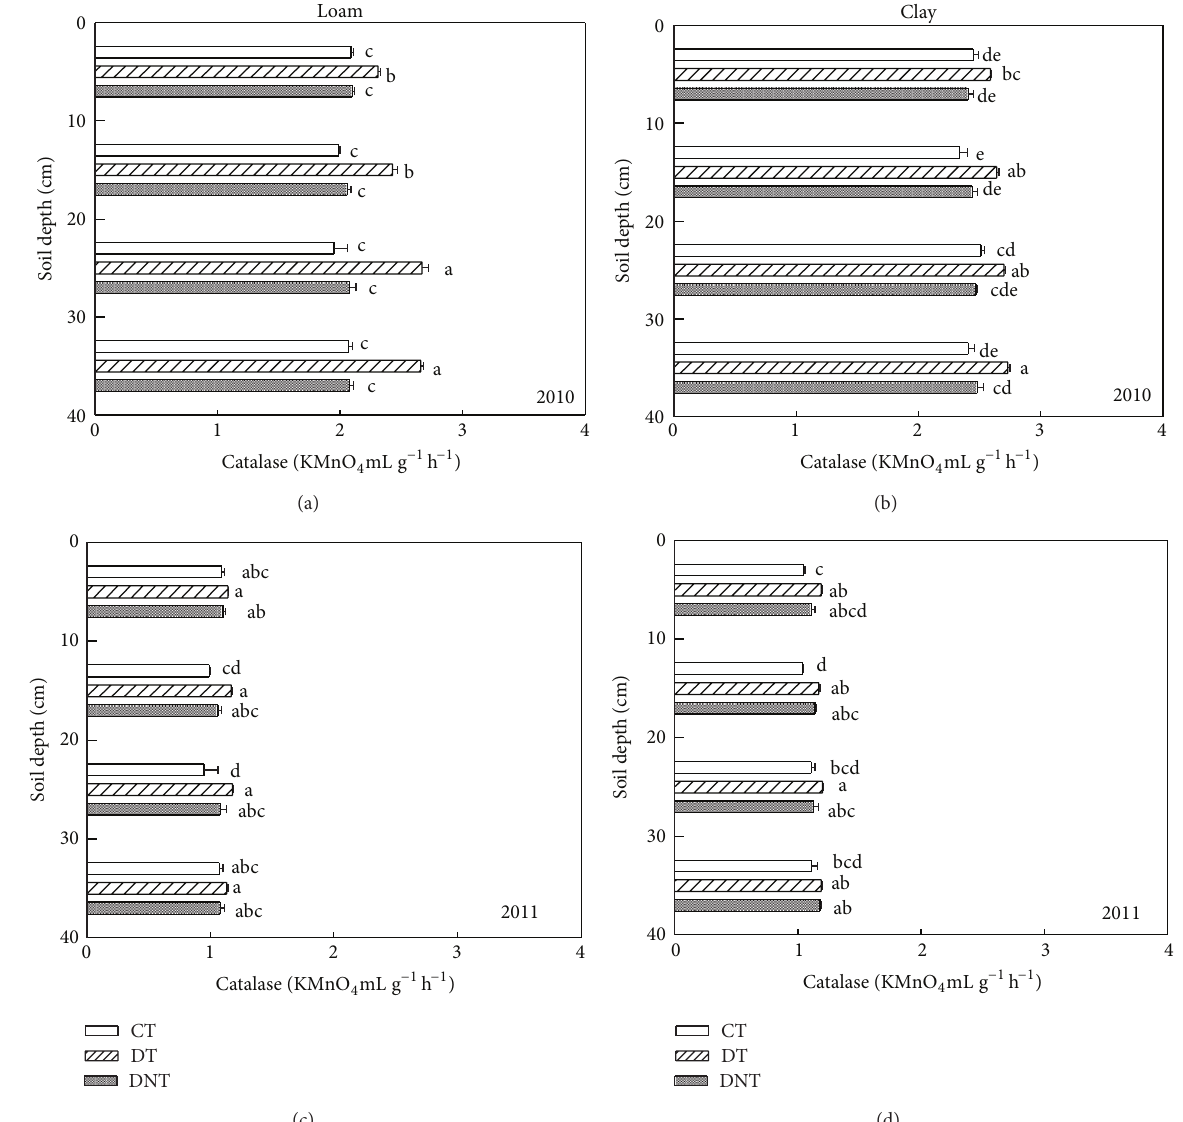
Figure 7: Effects of tillage and straw returning on soil catalase activity. Different small letters indicated significant difference at 𝑃 < 0.05 according to Duncan’s test. CT represented conventional tillage, moldboard ploughed to a depth of 20 cm, and straw was returned. DT represented deep tillage moldboard ploughed to a depth of 30 cm and straw was returned. DNT represented deep tillage moldboard ploughed to a depth of 30 cm and straw was